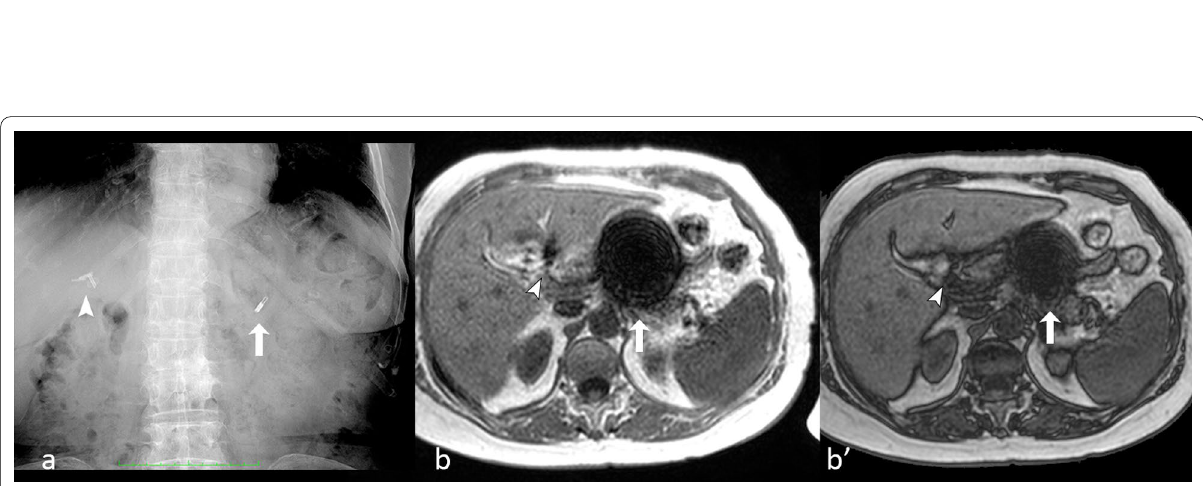
Fig. 8 Abdominal X-ray ( a ) showing two metallic devices in the right (arrowhead) and left (arrow) upper quadrants, respectively. The devices cause magnetic susceptibility-related artifacts on in-phase ( b ) and opposed-phase ( b ′ ) gradient echo (GE) T1-w. images in the stomach (arrow) and hepatic hilum (arrowhead), respectively; the signal intensity loss is higher on in-phase image ( b ). It is worthy of note that the magnetic device in the stomach (a ferromagnetic steel clip) causes a much more prominent artifact than the device in hepatic hilum (a paramagnetic titanium clip by previous